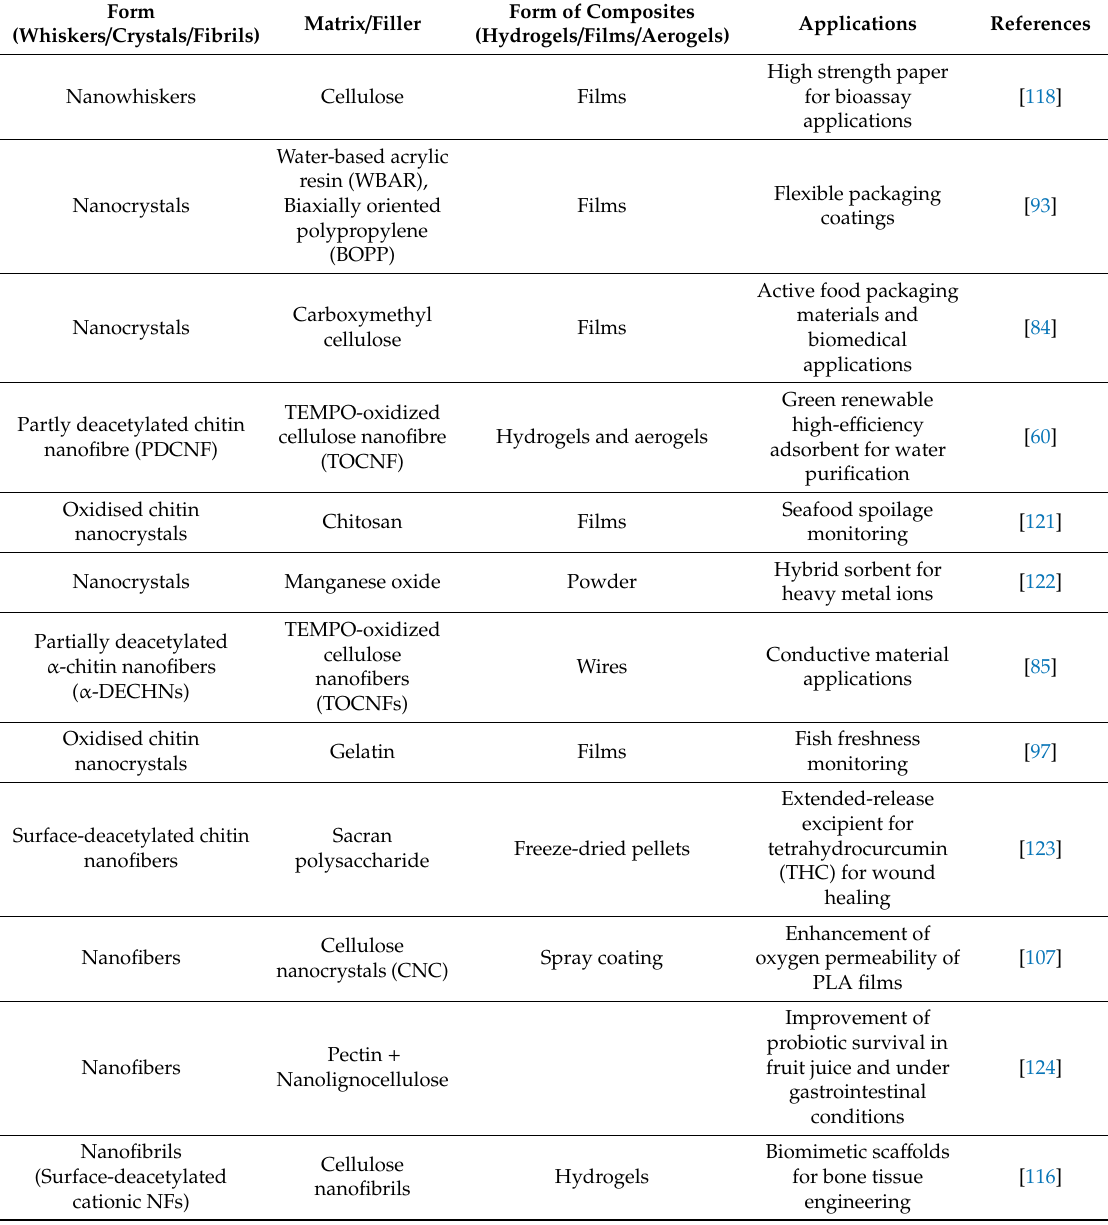
Table 1. Recent applications of chitin